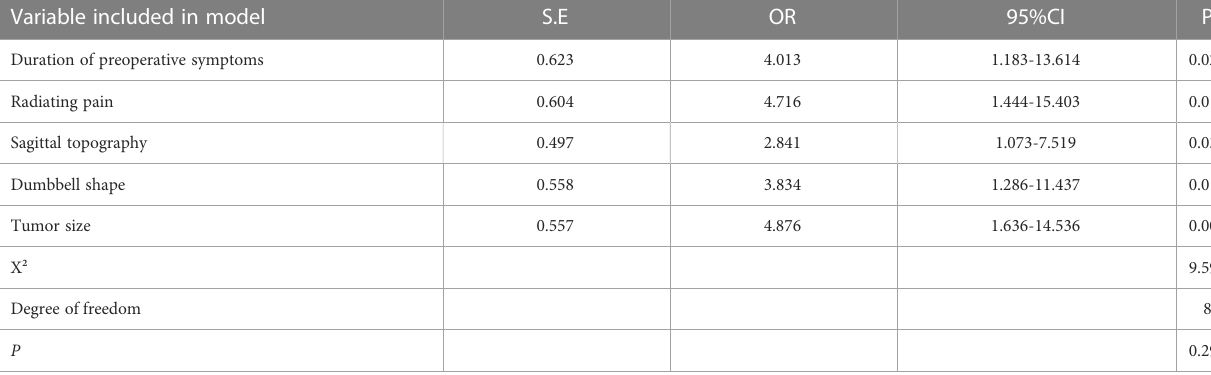
TABLE 4 Multivariate logistic regression model for post-operative neurological deterioration. Variable included in model